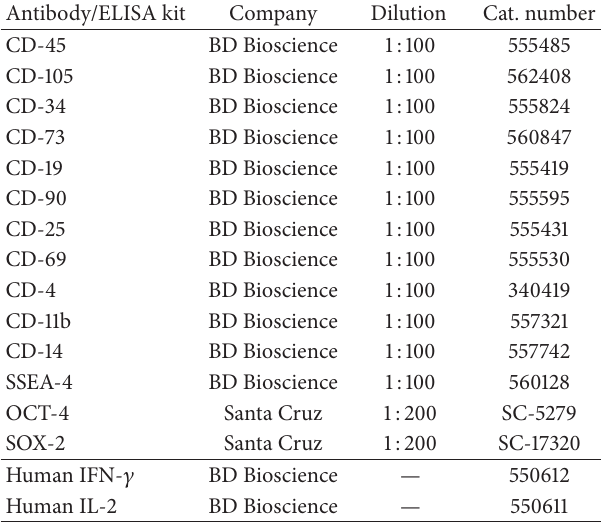
Table 1: List of antibodies and ELISA kits used in this study. Antibody/ELISA kit